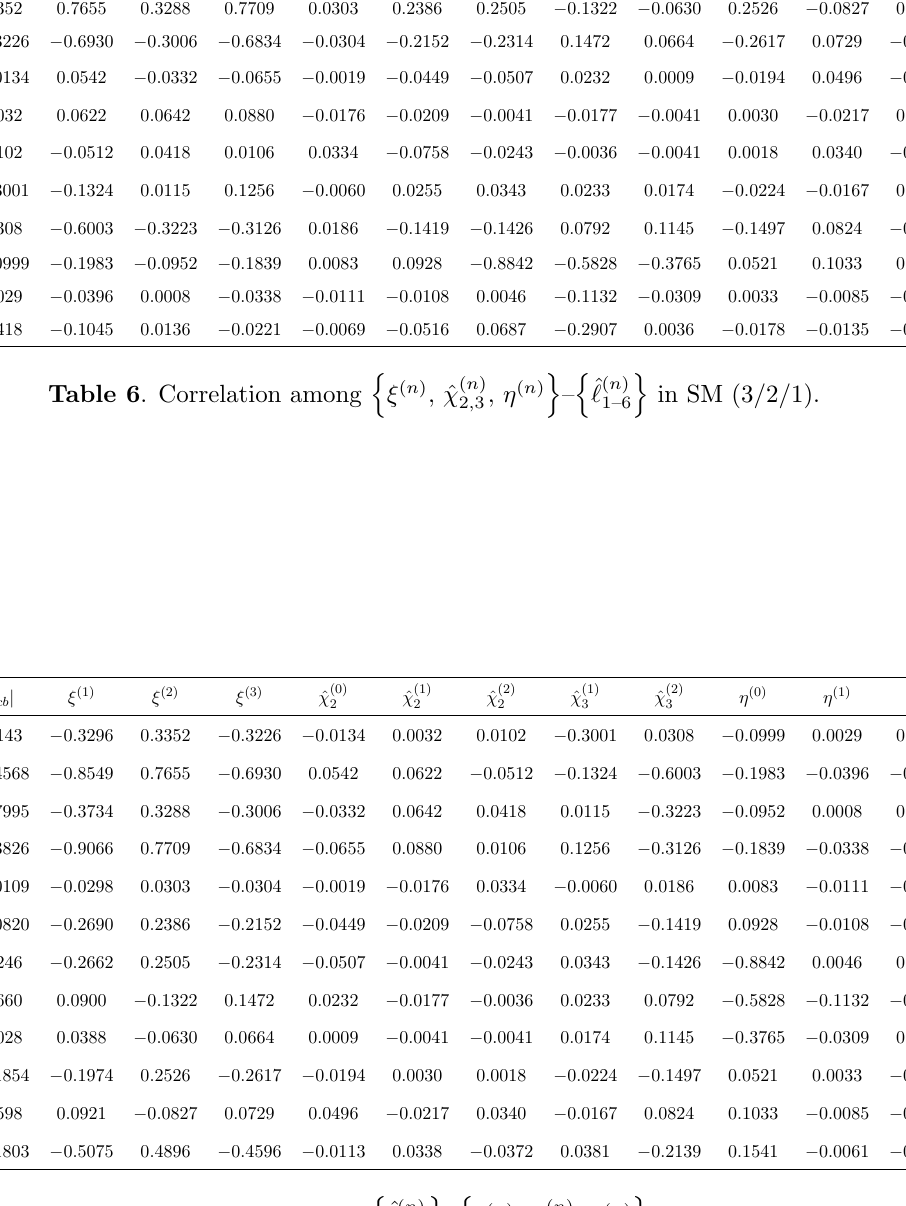
Table 7 . Correlation among